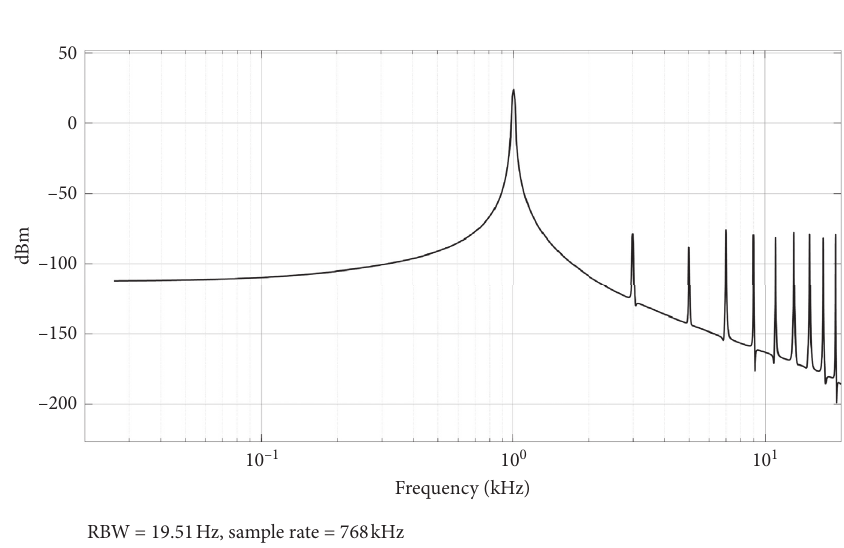
Figure 4: Output spectrum of the 16x interpolation filter.